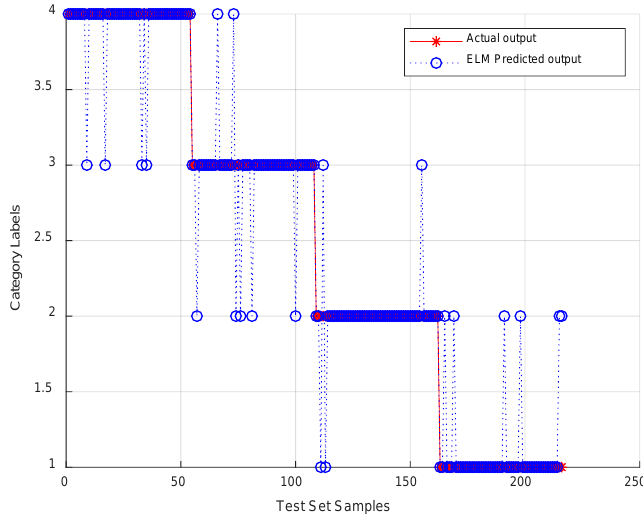
Figure 10. ELM (150 nodes)-based fatigue state detection results.